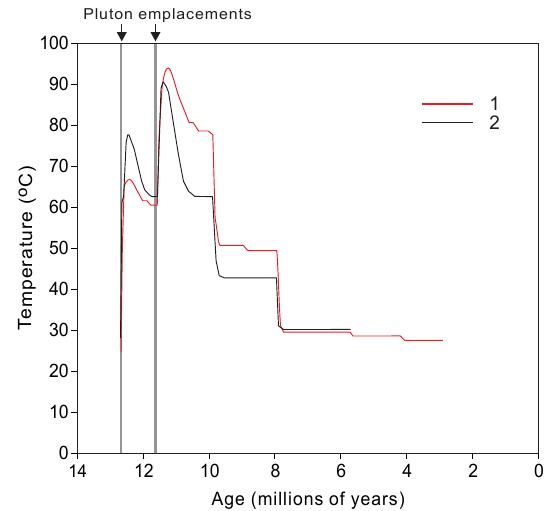
Figure A1. Reproducibility simulation: (1) Result of Whelan et al. (2008; Fig. 8; z = 300m at 11.5Ma, linearly decreases to 200m at present); (2) this study ( z = 300m). Mesh design, parameters of the model, and model scenario are as given in Supplement 1. Abrupt temperature drops at 10 and 8Ma reflect decreases in con- vective heat transfer specified (by setting lower values for poros- ity/permeability) in model scenario.